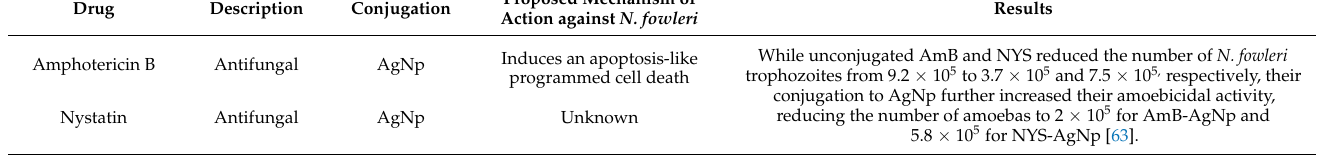
Table 3. Drugs conjugated with metal nanoparticles being studied to determine their amoebicidal activity against N. fowleri .